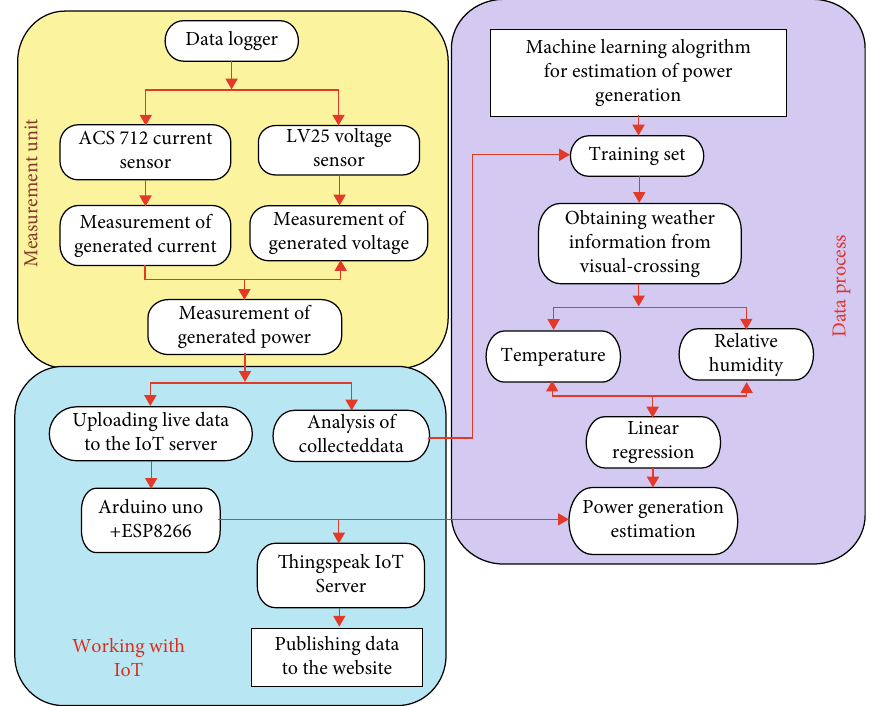
Figure 3: The methodology of proposed machine learning-based power forecasting in SAPV